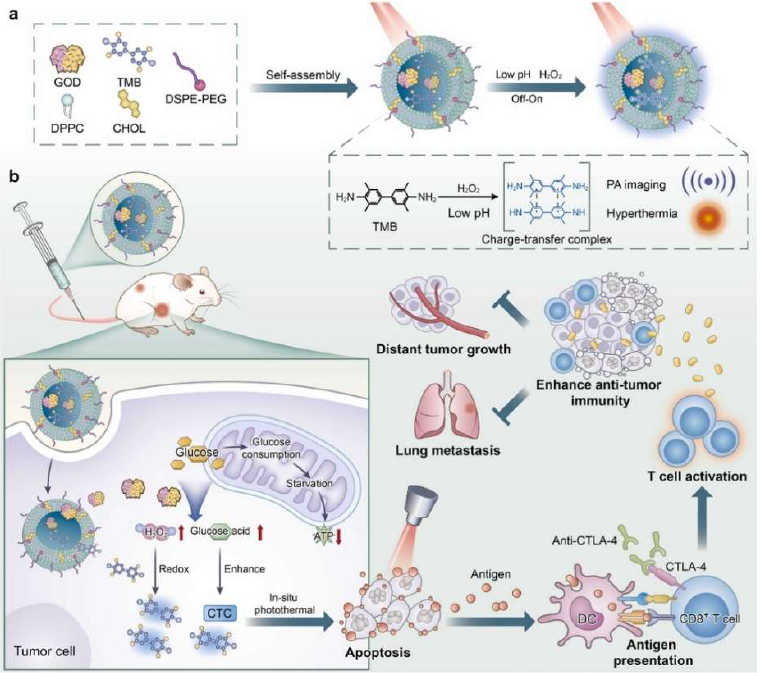
Figure 1. ( a ) A schematic illustration of the fabrication of a liposome-based cascade nanoreactor (LGT) containing TMB and GOD. ( b ) A schematic illustration of the NIR-II laser-triggered in situ NIR-II PTT and the starvation combinational immunotherapy. Reproduced with permission from [54]. Copyright 2022, Elsevier.